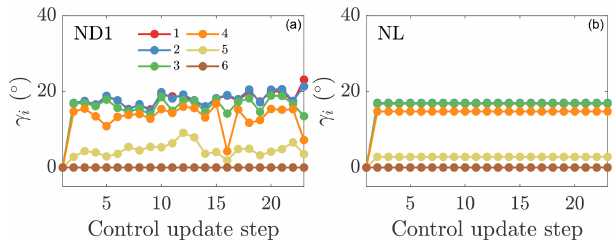
Figure 10. Relationship between the LES wind farm power pro- duction compared to the wake model wind farm power production prediction for (a ) online control using the initial parameters to ini- tialize the next state (ND1) and (b) the lookup table control (NL). The wind farm power is normalized by the power production of the aligned wind farm case. The LES power production is given by P , and the wake model prediction is given by ˆ P